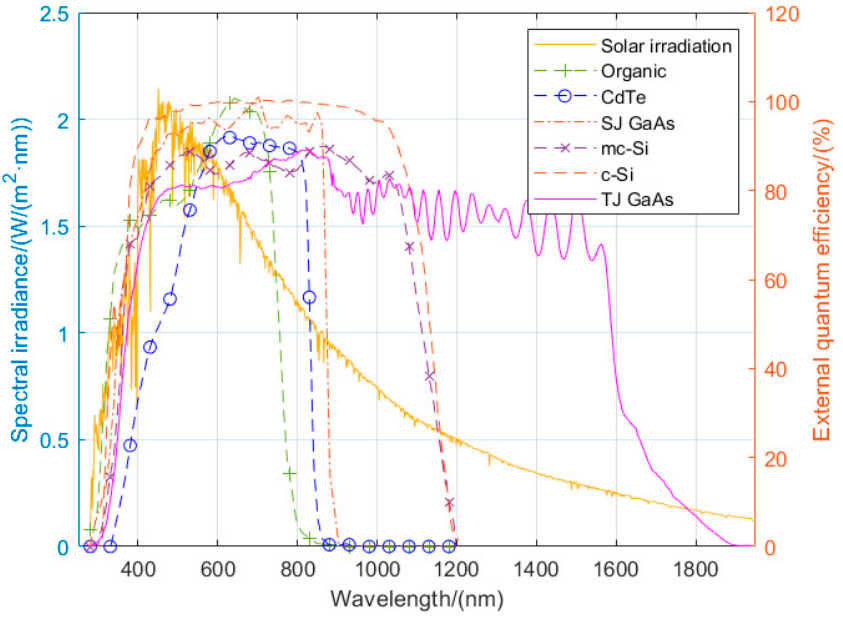
Figure 2. Different types of solar cell spectrum response and solar irradiation energy distribution [24]. Adapted with permission from Ref. [23]. Copyright (2022) Elsevier.